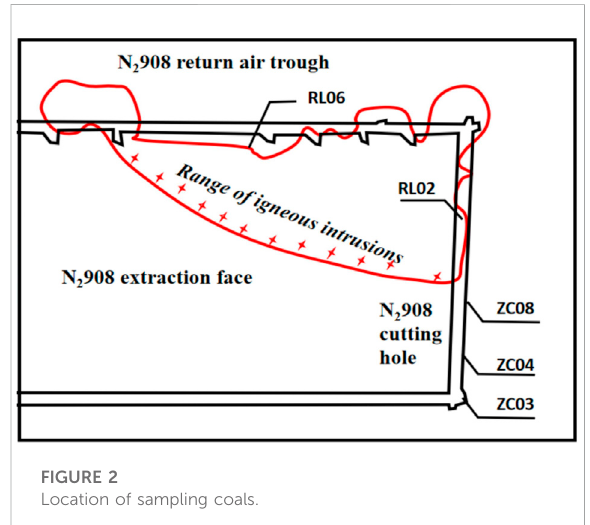
FIGURE 2 Location of sampling coals.